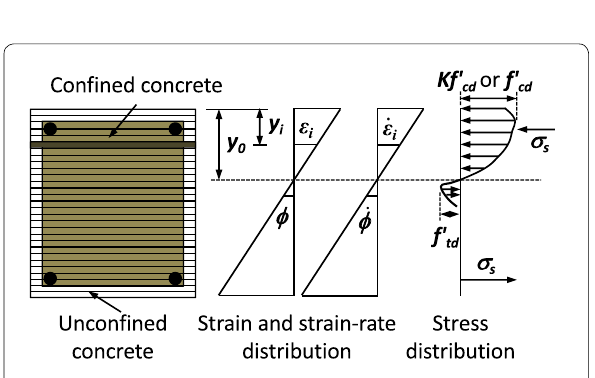
Fig. 9 Fiber analysis